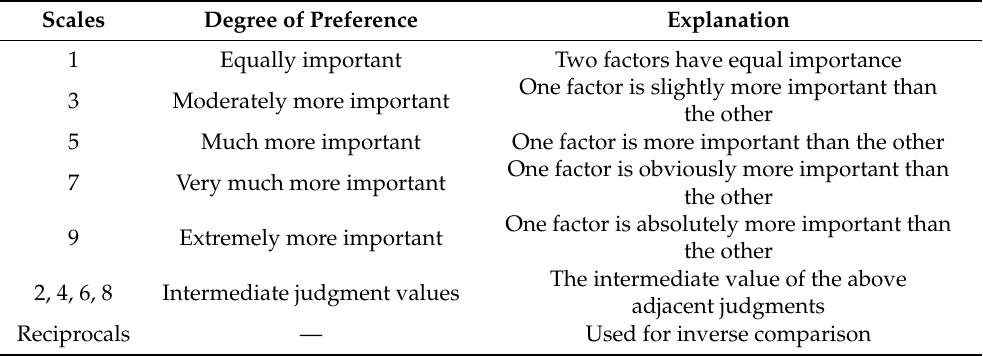
Table 2. Scale of preference between two parameters in AHP [60].